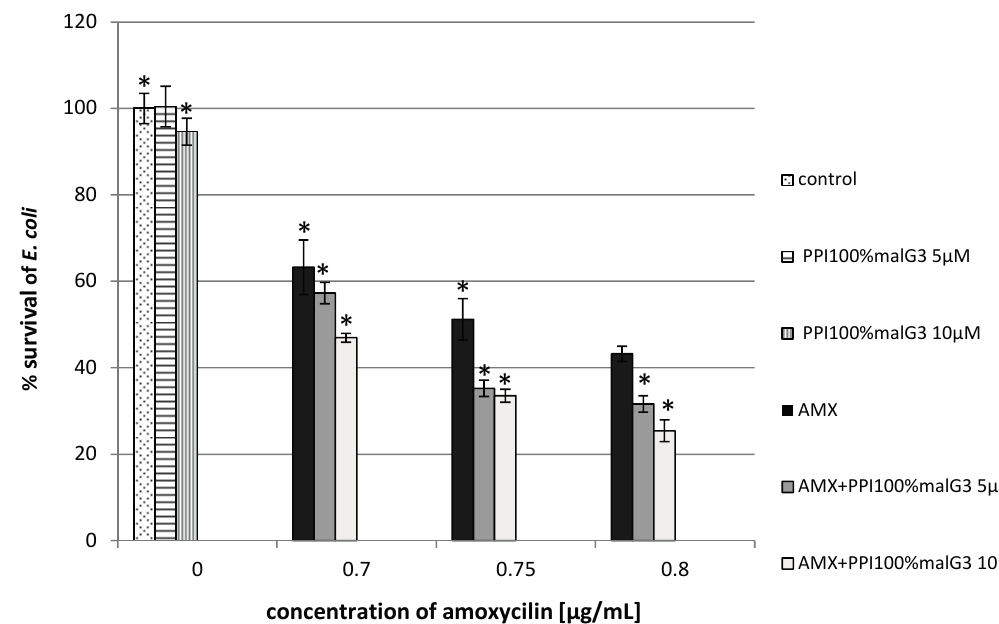
Figure 5. Growth of E. coli after 24 h of incubation with poly(propylene imine) dendrimers with a surface modified by attaching maltose in 100% (PPI 100%malG3) or/and amoxicillin. Each bar represents and the mean and SD of n ≥ 3 wells from three independent